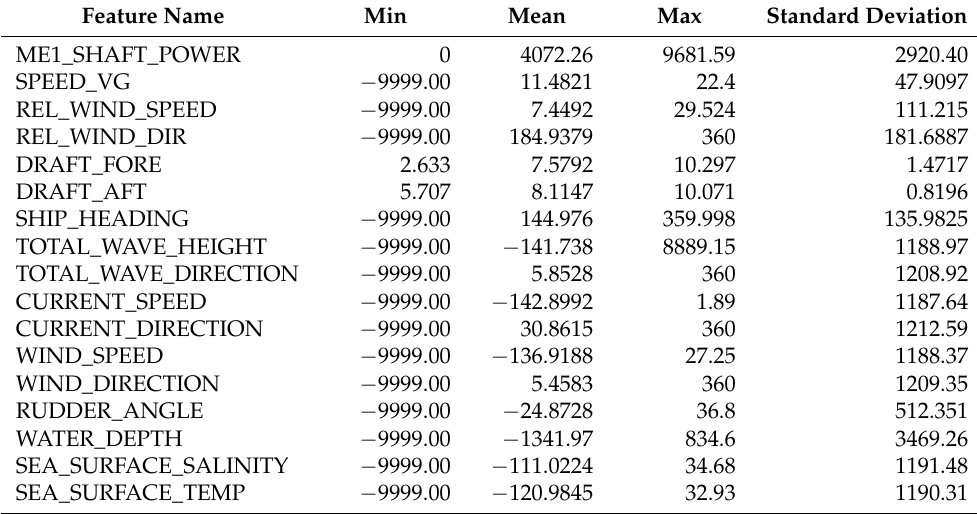
Table 3. Features the summary